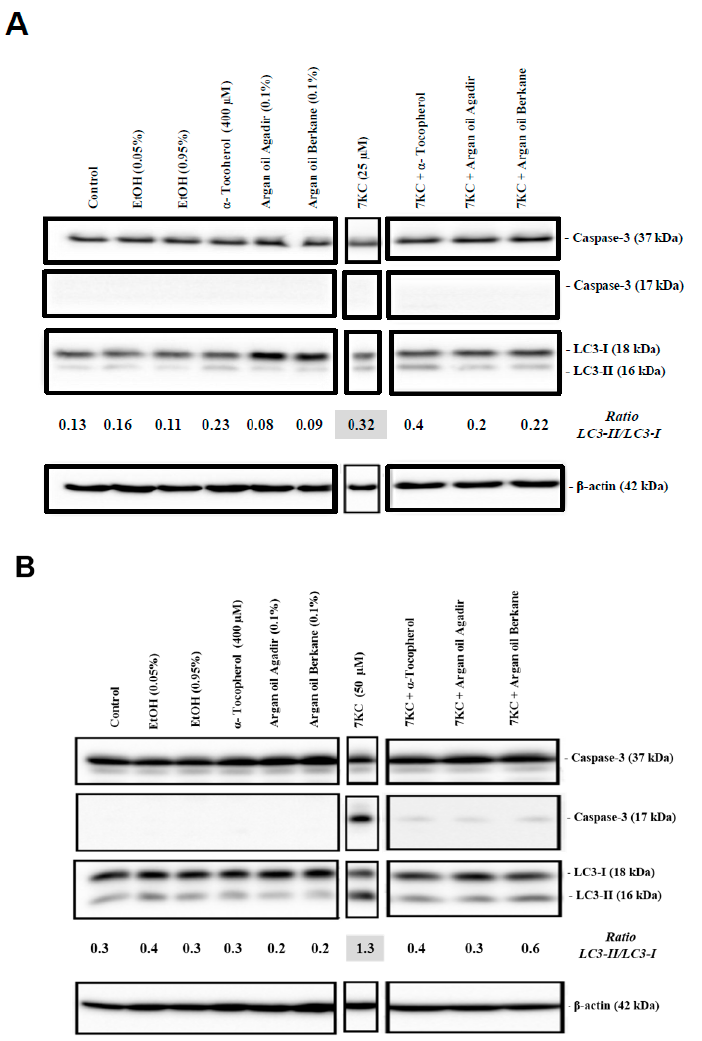
Figure 8. Effects of argan oil on 7-ketocholesterol-induced cleaved caspase-3 and activation of LC3-I into LC3-II. After 24 h of culture, 158N murine oligodendrocytes were cultured for an additional 24 h without or with 7KC (25 µM) ( A ) or with 7KC (50 µM) ( B ) in the absence or presence of argan oils (Agadir or Berkane; Morocco; 0.1% v / v ) or of α -tocopherol (400 µM) used as the positive control. Argan oils and α -tocopherol were added to the culture medium 2 h before 7KC. Apoptosis was evaluated by caspase-3 activation (cleaved caspase-3) and autophagy by conversion of LC3-I to LC3-II (increased LC3-II/LC3-I ratio). The EtOH values (0.05%, 0.1% and 0.9% v / v ) correspond to the final EtOH concentration in the culture medium with 7KC (25 µM), 7KC (50 µM) and argan oils, respectively. No difference was observed between control and vehicle (EtOH)-treated cells. Data shown are representative of three independent